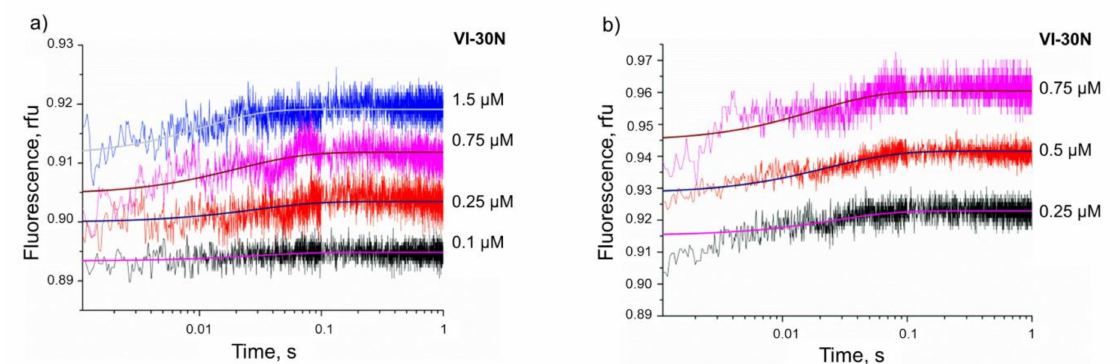
Figure 3. Kinetic curves characterising the interaction of Nt.BspD6I (1 µ M) with non-specific DNA duplex VI-30N (concentrations are shown next to the curves): in the presence of ( a ) 10 mM CaCl 2 or ( b ) 10 mM MgCl 2 . Coloured dots indicate experimental data, and solid curves denote calculated kinetic curves corresponding to Scheme 1. Rfu: relative fluorescence